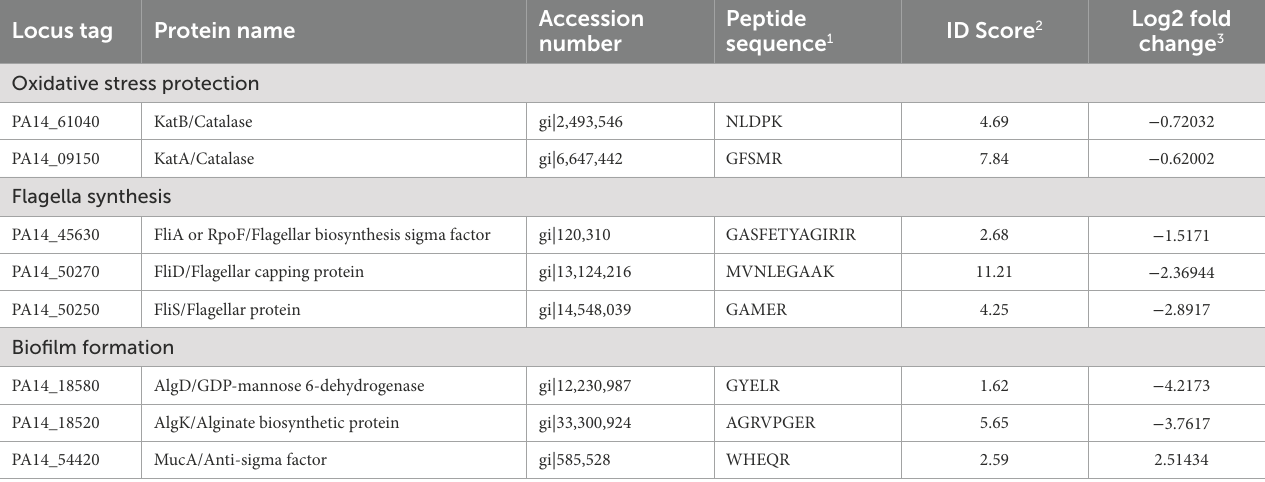
TABLE 3 List of differentially produced proteins in gidA mutant compared to Pseudomonas aeruginosa wild type discussed in this report. Locus tag Protein name